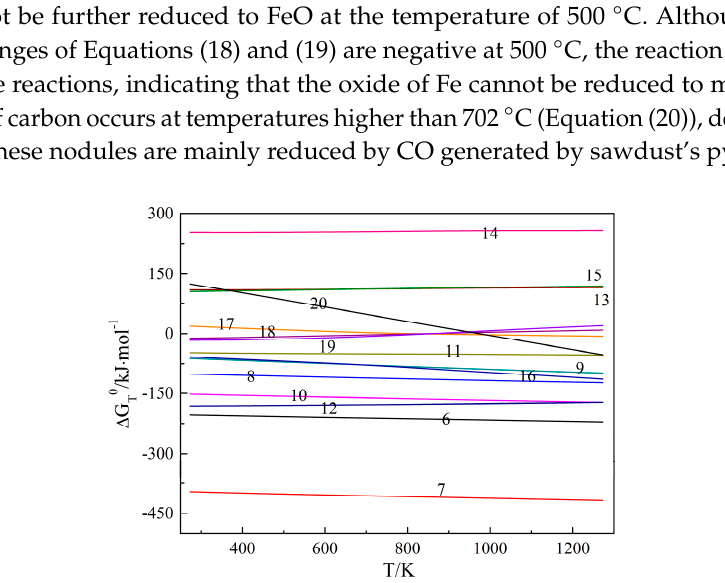
Figure 9. The relationships between T and △ G T0 for Equations (6)–(20).